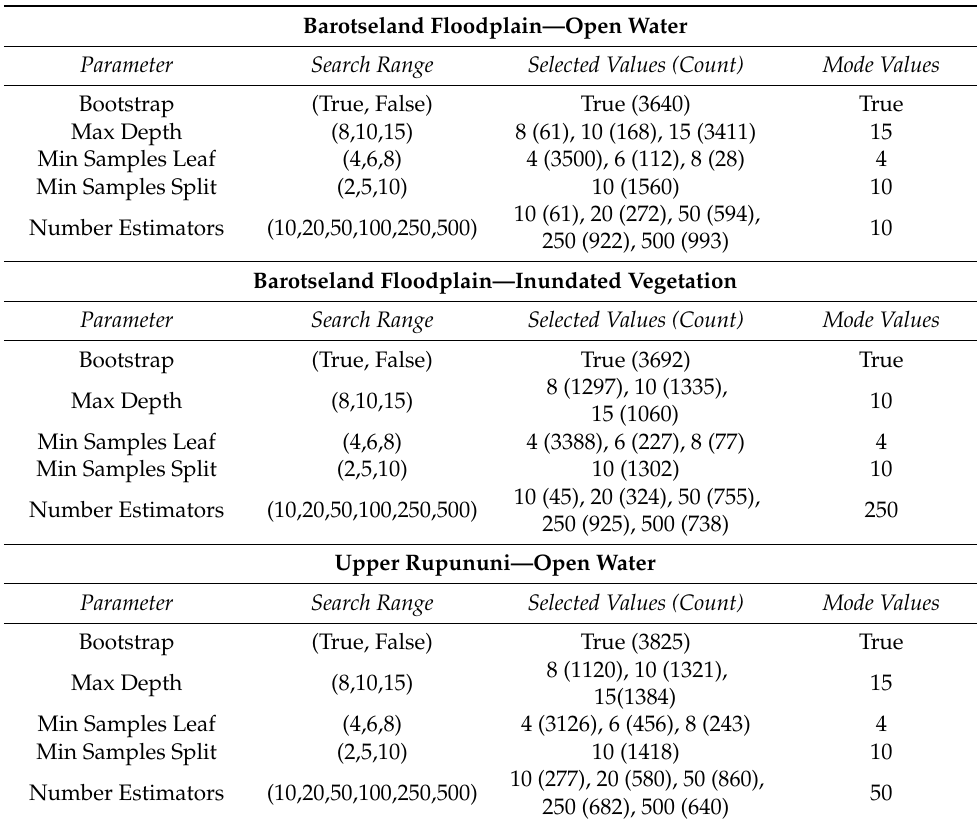
Table 3. Extra Random Forest hyperparameters used in grid search selection for each classification replicate. The count of each hyperparameter used in each classification replicates over the accuracy assessment scenes is included as well as the most commonly used classification